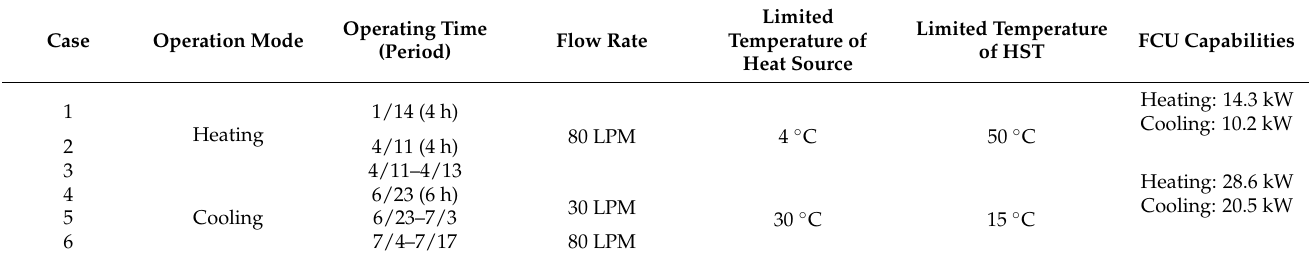
Table 4. Experiment condition.